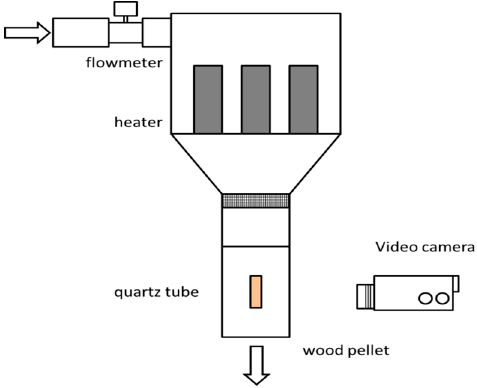
Figure 9. Schematic diagram of experimental